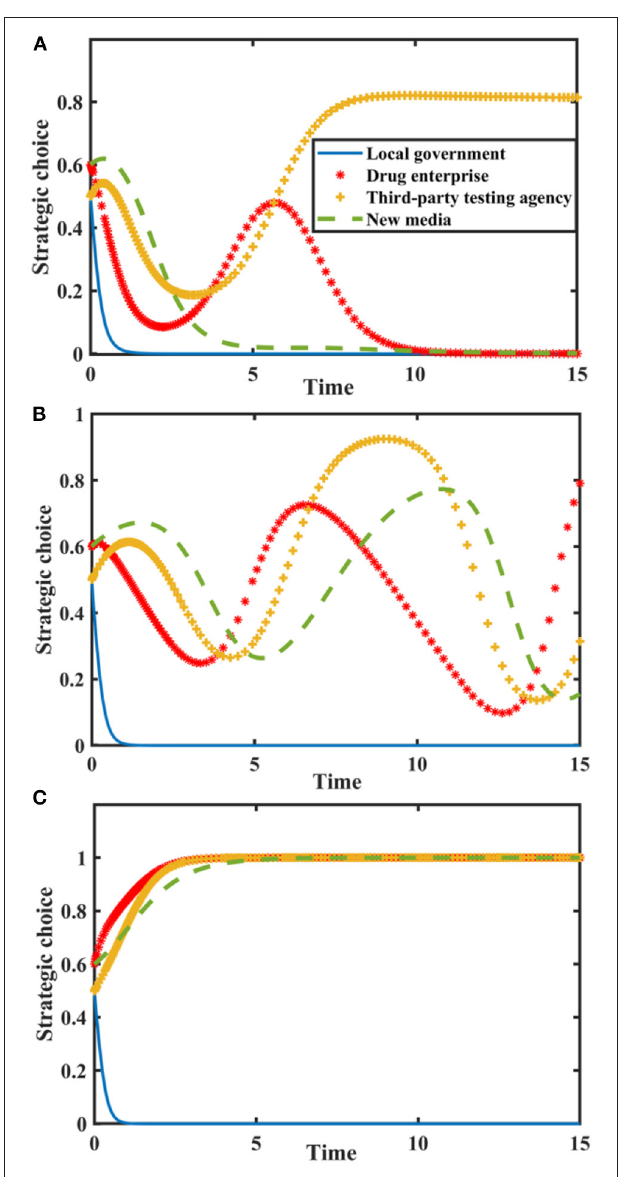
FIGURE 6 | Impact of I and N on the evolution of each player’s strategy. Figure is the simulation diagram that shows the influence of the reputation value brought by new media true reporting and reputation loss brought by new media distorted reporting on the strategic choices of local government, drug enterprises, third-party testing agencies, and new media. (A) When the situation I = 0.0, N = 0.0. (B) When the situation I = 2.0, N = 3.0. (C) When the situation I = 4.0, N = 6.0.